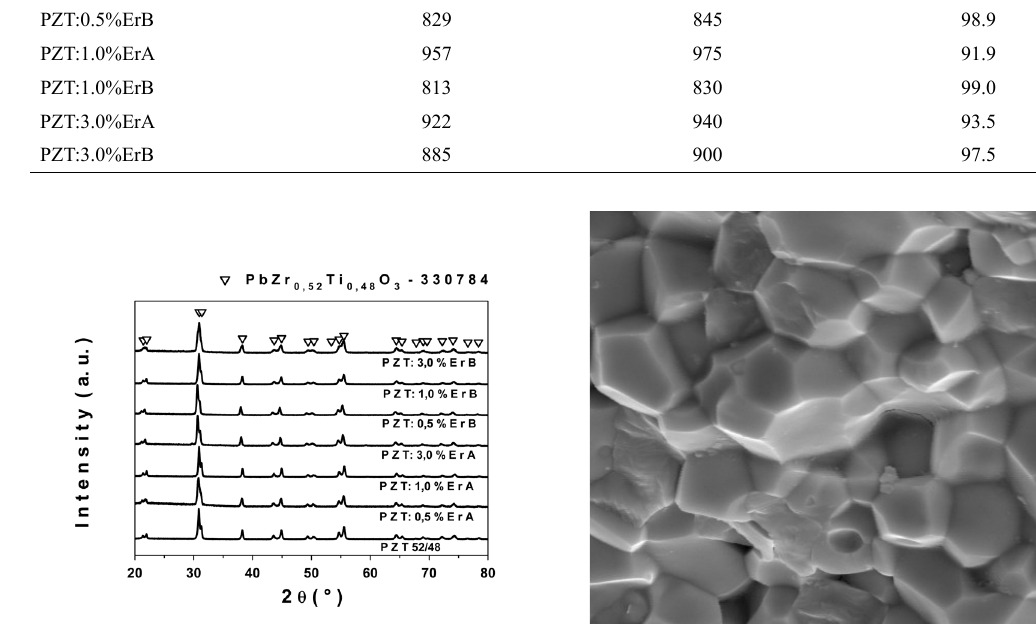
Figure 7. X-ray diffraction patterns of sintered ceramics (all compositions).